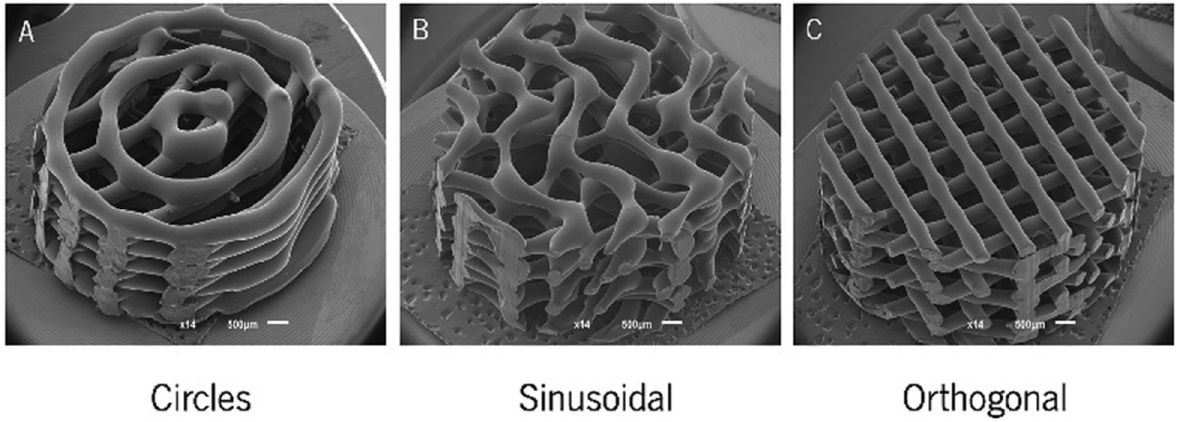
Figure 3. SEM micrographs of the ( A ) circle, ( B ) sinusoidal, and ( C ) orthogonal scaffolds produced [70]. Copyright 2018 MDPI.